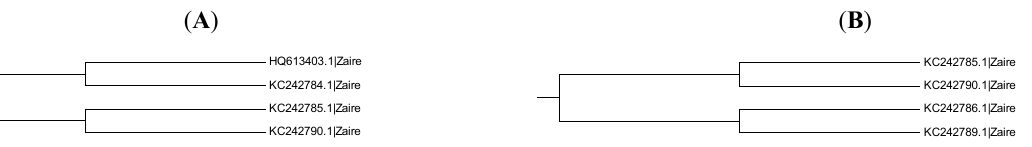
Figure 10. ( A ) The second clade for the tree in Figure 9A; ( B ) The second clade for the tree in Figure 9B. Table 5. The p-values for testing the nucleotide substitution number between sequences in the second clade for the tree in Figure 9A.